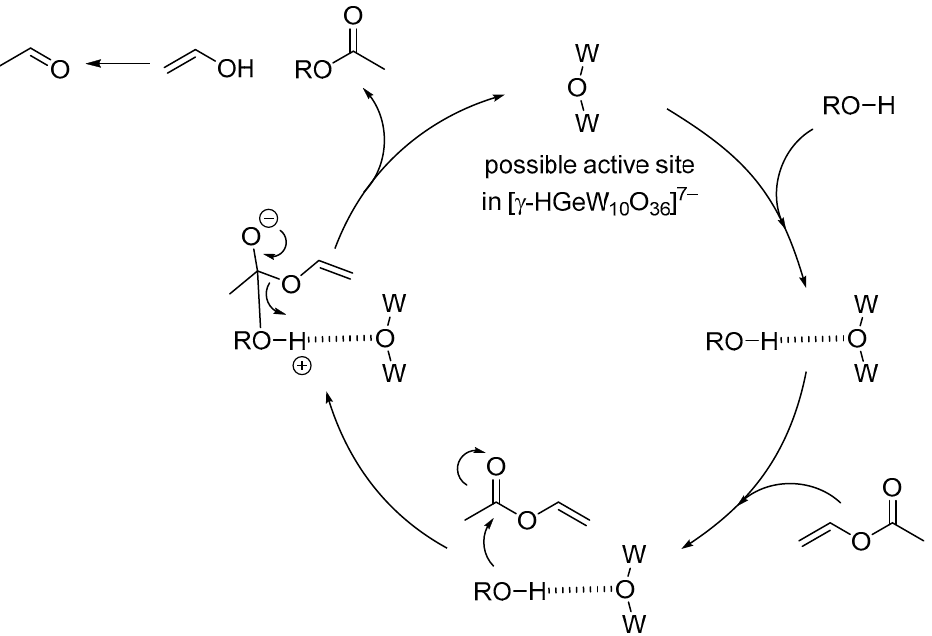
Figure 12. Proposed mechanism for the chemoselective acylation of alcohols with vinyl acetate catalyzed by [ γ -HGeW 10 O 36 ] 7 − [46].